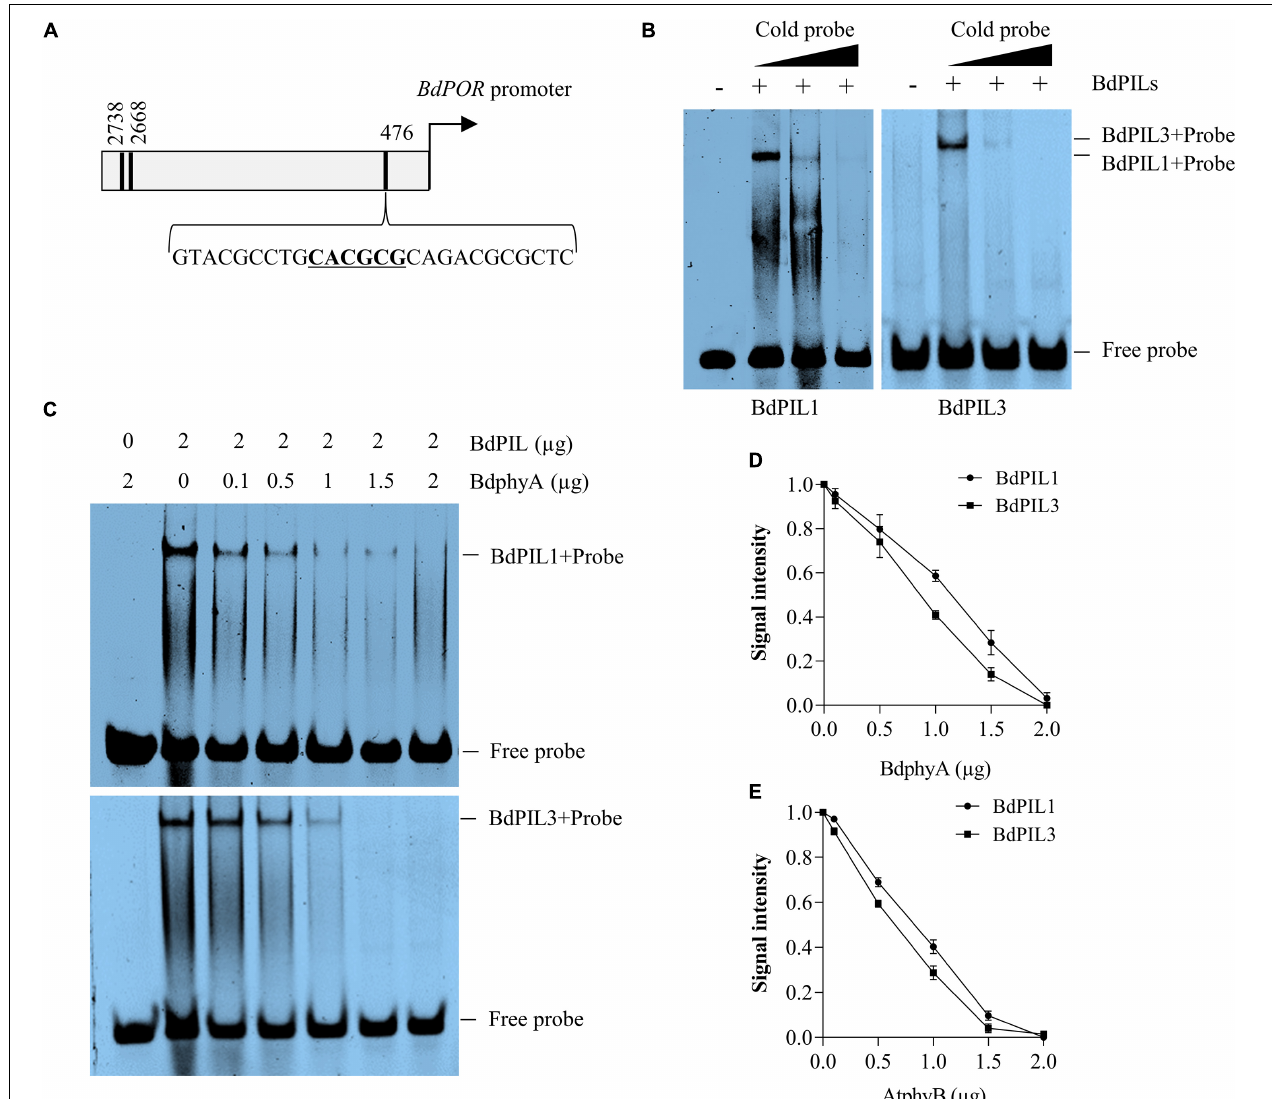
FIGURE 7 | DNA-binding ability of BdPIL1 and BdPIL3 and the effects of phytochrome interactions. (A) A diagram depicting the promoter region of BdPOR . Locations of the predicted motifs (E- and N-boxes) for the binding of BdPILs are indicated with black lines. The third motif (underlined) was chosen as a probe. (B) DNA-binding ability of BdPIL1 and BdPIL3. Electrophoretic mobility shift assay (EMSA) was conducted by incubating BdPIL1 or BdPIL3 with 32 P-labeled probe (labeled “+”). BSA was included as a negative control (labeled “–“). Competition assays were performed with 10 × and 20 × cold probes. (C) Effects of phytochrome interaction with BdPIL1 and BdPIL3 on their DNA-binding ability. BdPIL1 or BdPIL3 was incubated with the indicated concentrations of BdphyA (Pfr form) before EMSA. As negative controls, BdphyA with the 32 P-labeled probe was included in the first lanes. (D,E) Quantification of DNA binding. Different amounts (0.1–2 µ g) of Pfr forms of BdphyA (D) or AtphyB (E) were added to the reaction mixtures containing 2 µ g of BdPIL1 or BdPIL3 before EMSA. DNA binding was estimated using the EMSA stains, and the signal from BdPIL-DNA complexes without phytochrome was assumed to be 1. Data represent the means ± SD of three independent